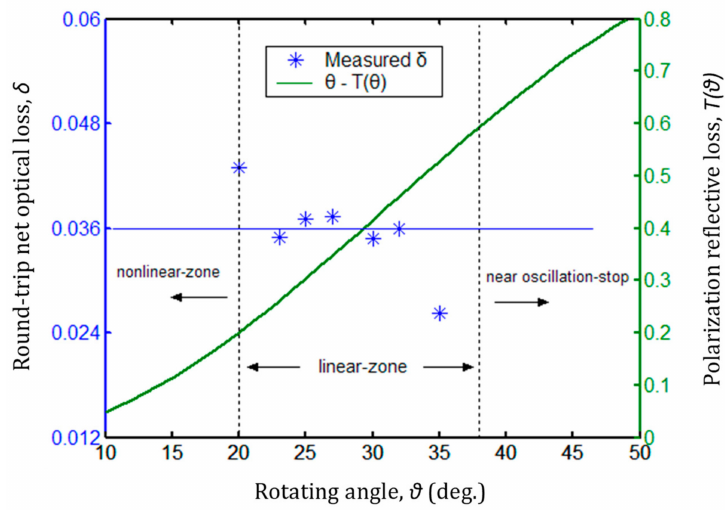
Figure 7. The round-trip net optical loss δ as a function of the rotating angle θ , and the rotating angle θ with respect to the polarization reflective loss T ( θ